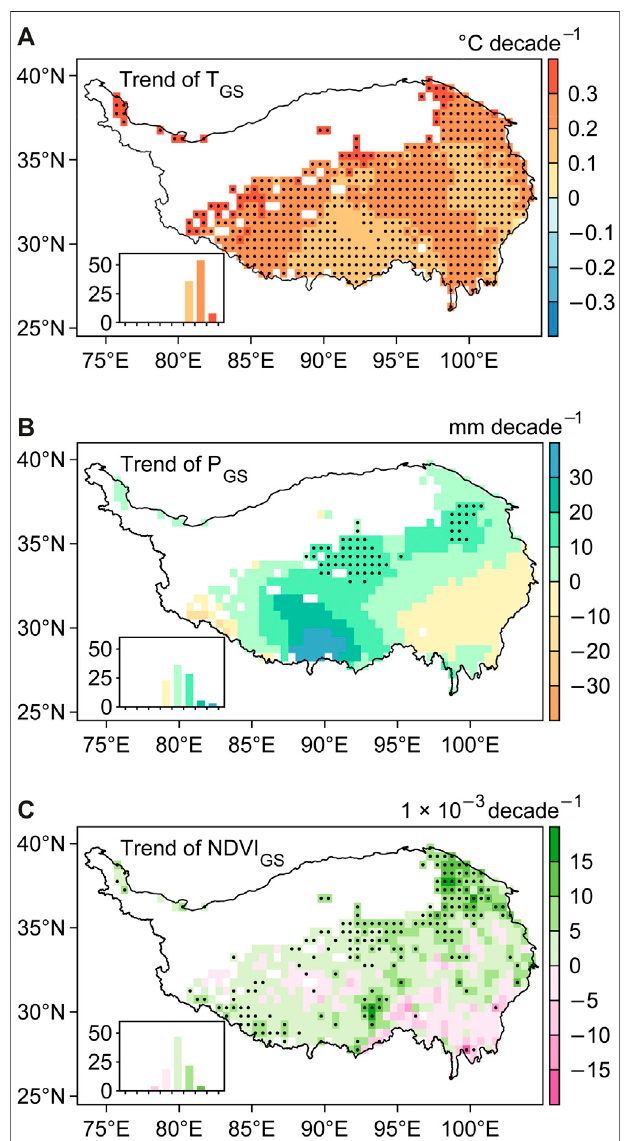
FIGURE 4 | Spatial pattern of temporal trends in T GS (A) , P GS (B) , and NDVI GS (C) . Pixels with dots were statistically signi fi cant ( P < 0.05). Bottom- left inset in each map shows the percentage of pixels in each trend interval. The trend interval values are indicated by the color scale to the